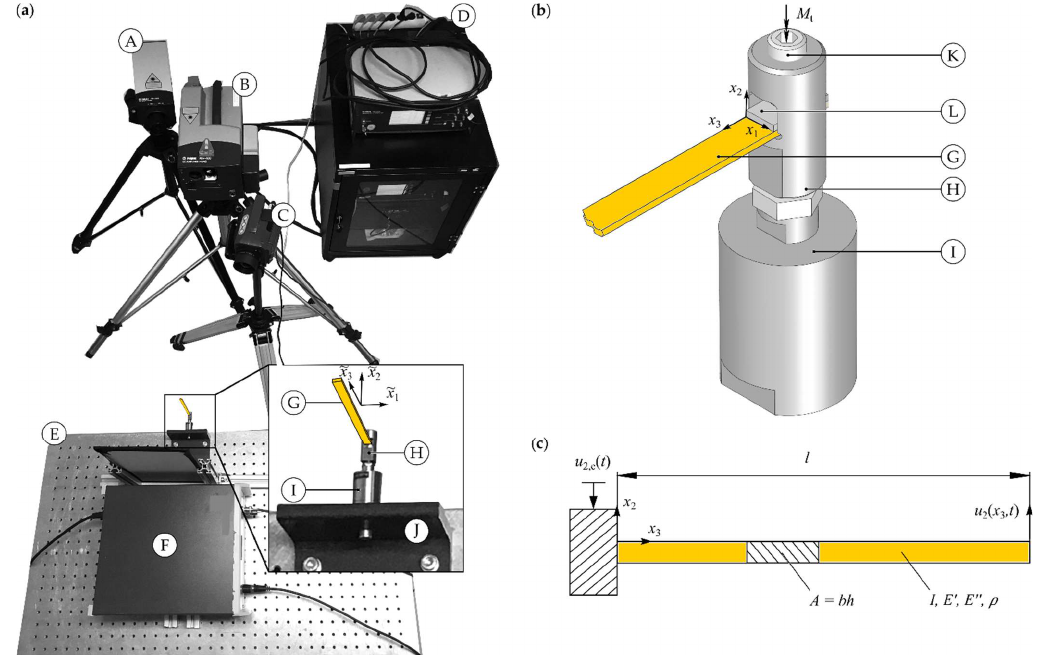
Figure 1. Experimental setup: ( a ) arrangement of the used measurement devices, ( b ) detailed view of the base-excited specimen, ( c ) simplified model (single point laser vibrometer, A; scanning laser vibrometer, B; infrared camera, C; function generator, D; optical table, E; amplifier, F; specimen, G; clamping adapter, H; fixed piezoelectric adapter, I; mounting of actor, J; grub screw, K; clamping plate, L).